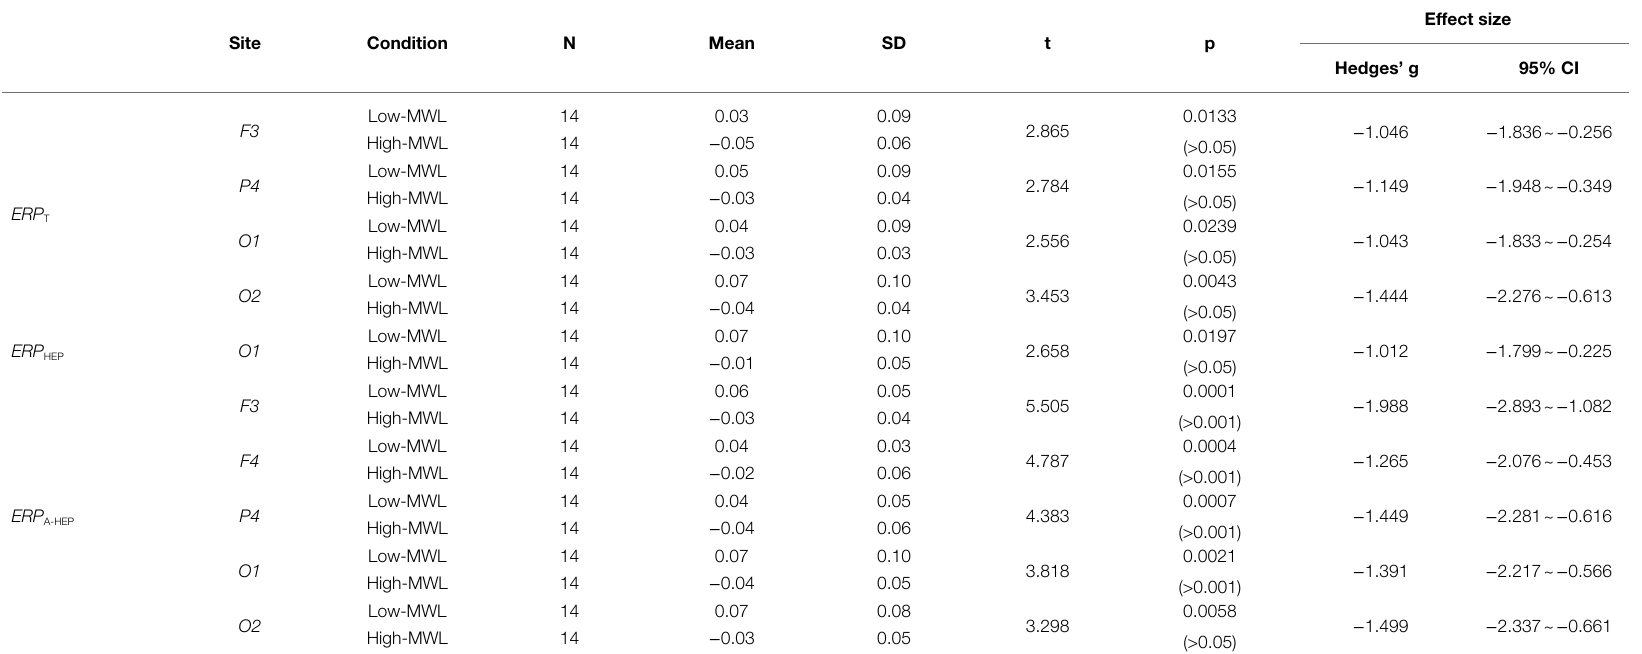
TABLE 1 | Comparison by paired t -test of the P600 amplitude between low- and high-MWL